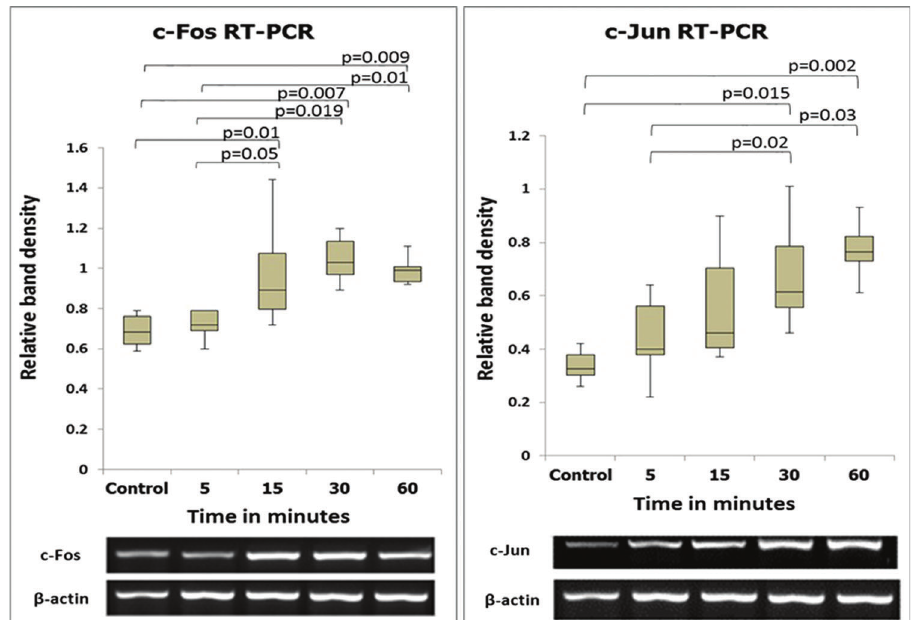
Figure 2 - The sequential expression patterns of c- fos and c- jun mRNA (semiquantitative method) and images of the respective bands. The numbers in the vertical axis correspond to the relative expression levels normalized to the internal control gene ( b -actin